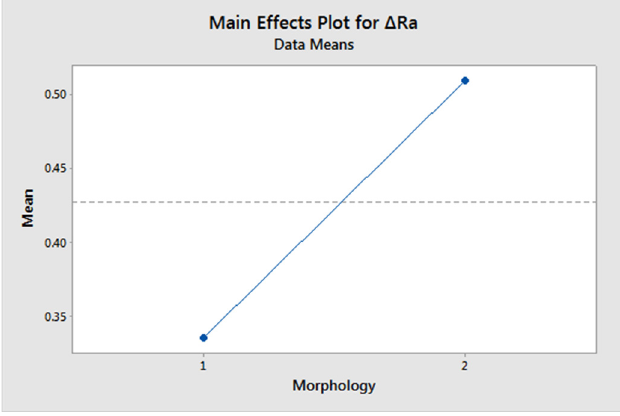
Fig. 7. The effect of abrasive particle morphology on D R a (1 =Spherical particles, 2 =Rod-shaped particles).